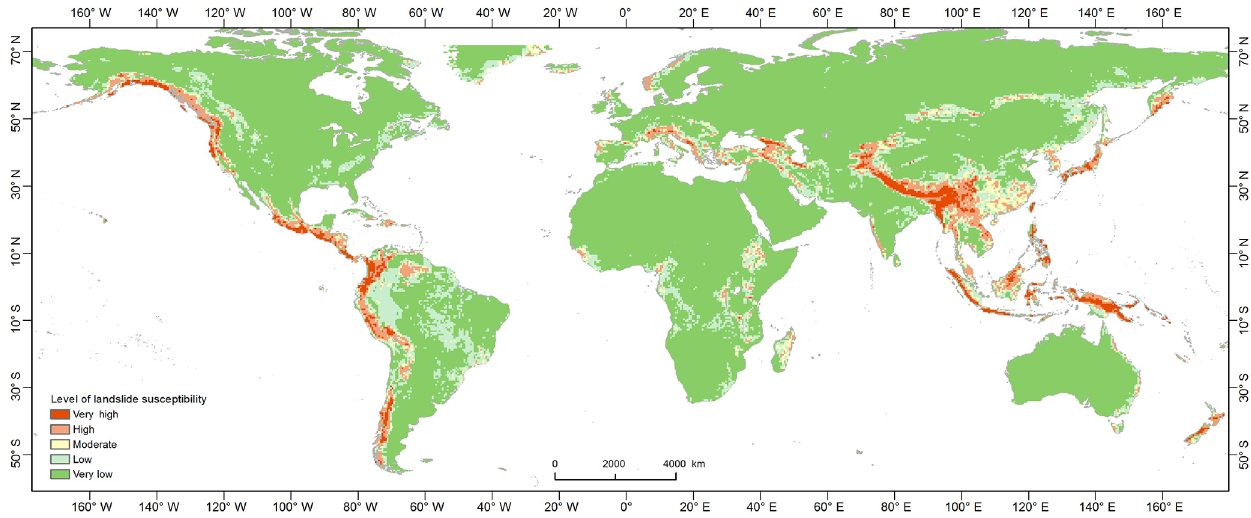
Figure 5. Global-scale landslide susceptibility